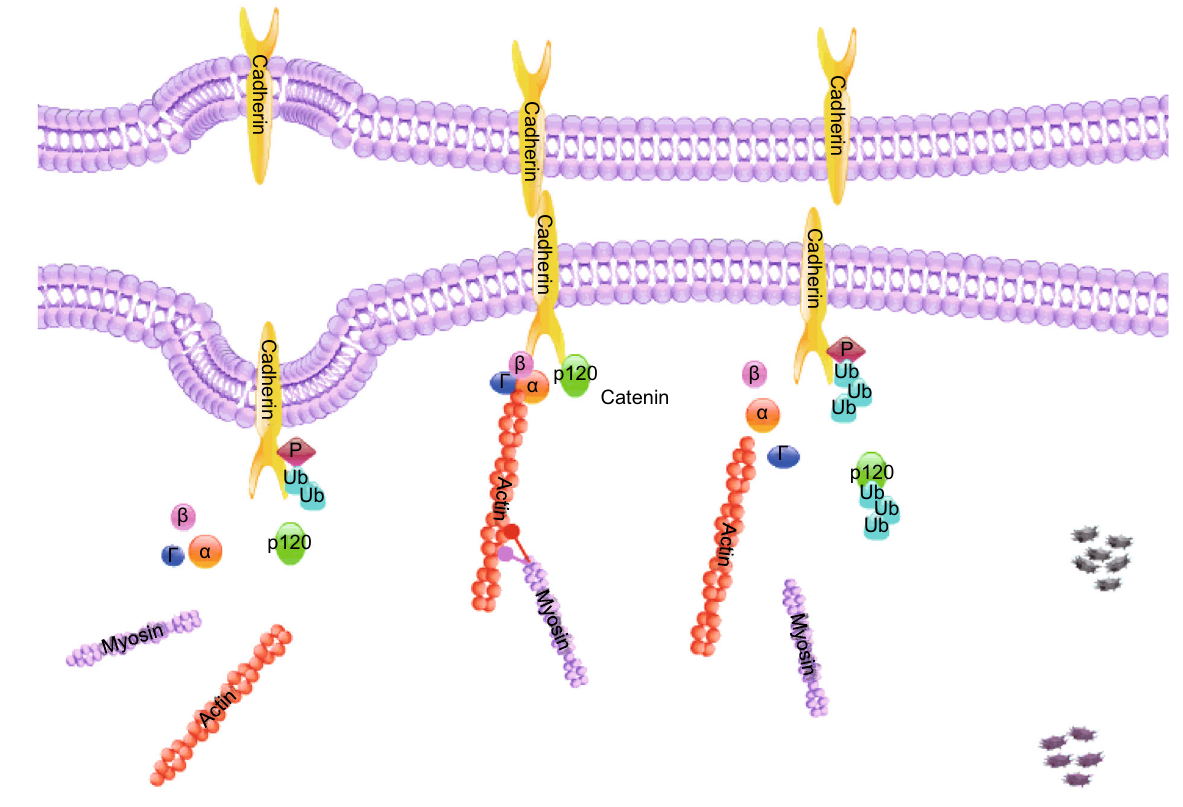
Figure 3. Schematic diagram of the cadherins endocytosis, degradation, and recycling. Phosphorylation triggers polyubiq- uitination of cadherin, which can be reversed by deubiquitinating enzymes. Ubiquitinated cadherin is degraded in the lysosome. Its linker, p120 catenin is ubiquitinated and degraded in the